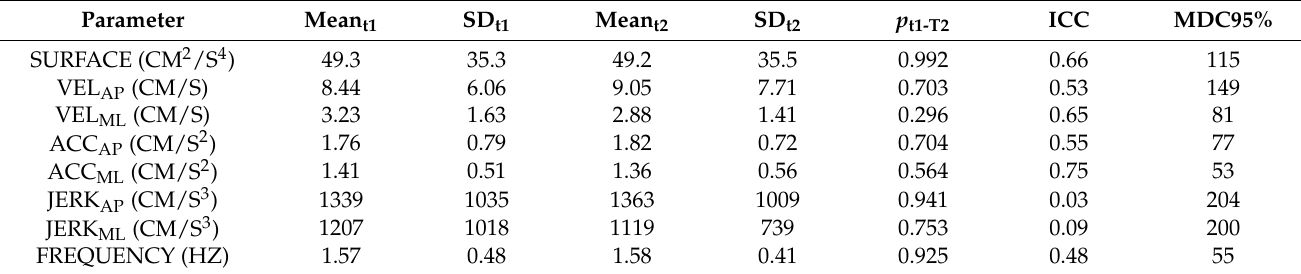
Table 4. Reliability and minimal detectable change: semi-tandem stance a soft surface (eyes open) ( n = 19). Parameter